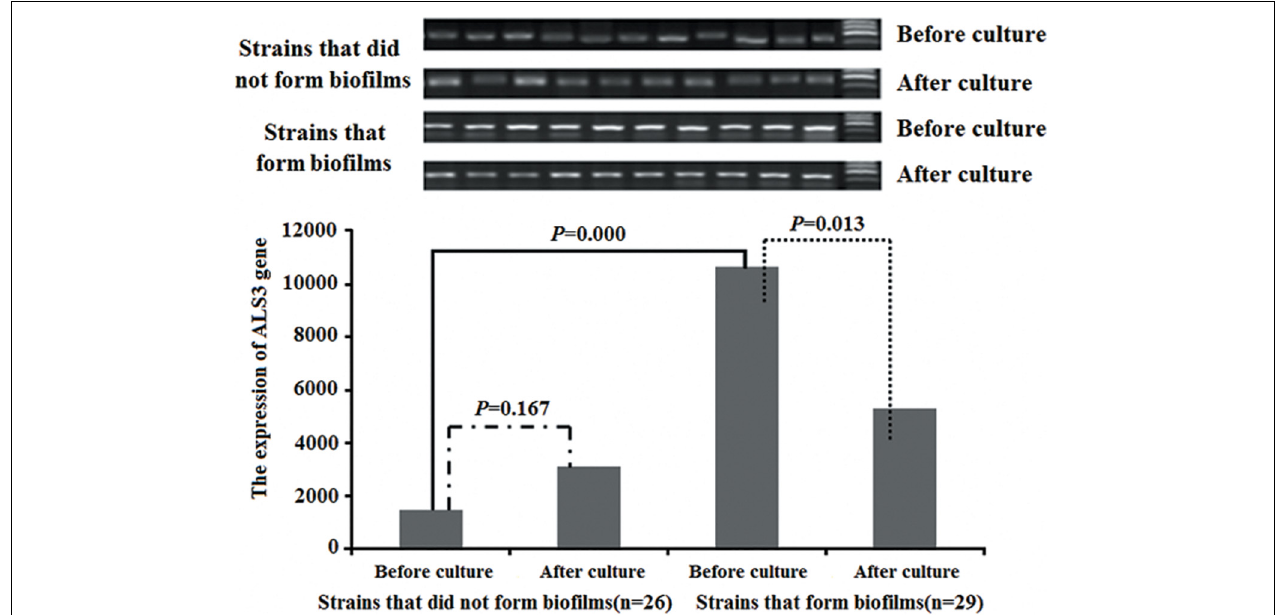
FIGURE 3 | The changes of the ALS3 gene expression. The average of ALS3 gene expression was higher in the 29 C. albicans with biofilm formation than that of in the 26 C. albicans without biofilm formation. The average of ALS3 gene expression declined after culture in the 29 C. albicans with biofilm formation. But there was no different in the 26 C. albicans without biofilm formation before and after